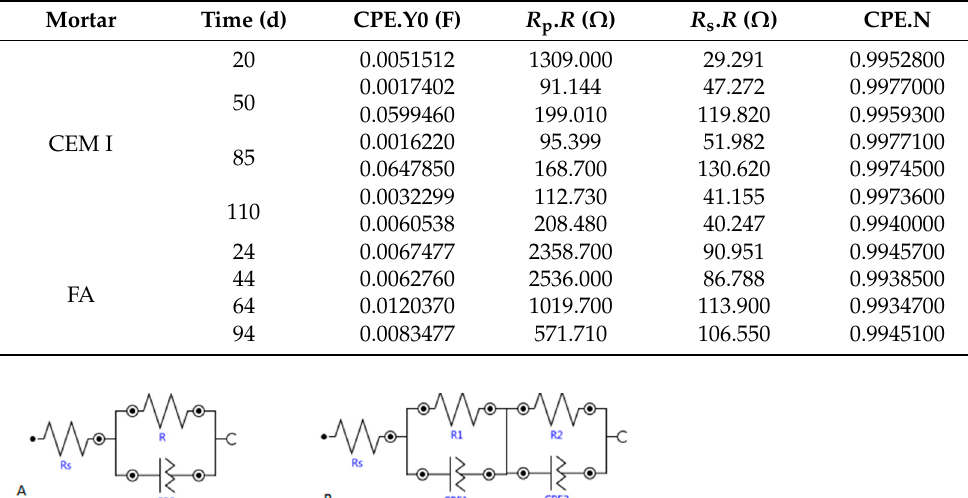
Figure 8. Equivalent circuits used for the EIS fitting. ( A ) Randles simple; ( B ) two serial RC circuits. Looking at the phase angle evolution, a reduction of this parameter is clearly appreciated at the lower frequencies in both cases, CEM I and FA, as can be better appreciated in bode diagrams presented in Figure 9.